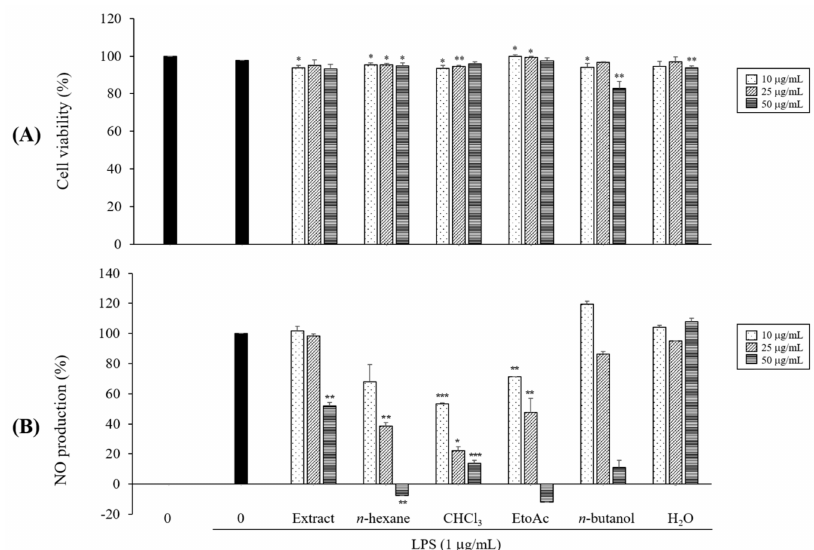
Figure 1. Cell viability ( A ) and nitric oxide (NO) production ( B ) of total extract and fractions from Selaginella tamariscina. RAW 264.7 cells were cultured in the presence of total extract and each fraction for 1 h and stimulated with lipopolysaccharide (LPS) (1 µ g/mL) for 24 h under serum-free conditions. Cell viabilities and NO production were determined using cell counting kit (CCK)-8 assay and Griess reagent, respectively. Nitrite concentrations of nontreated and LPS-treated controls were 4.63 ± 1.48 µ M and 30.35 ± 0.12 µ M, respectively. Each determination was made in triplicate. Data are presented as means ± SD. * p < 0.05, ** p < 0.01, *** p < 0.001 vs. LPS-treated